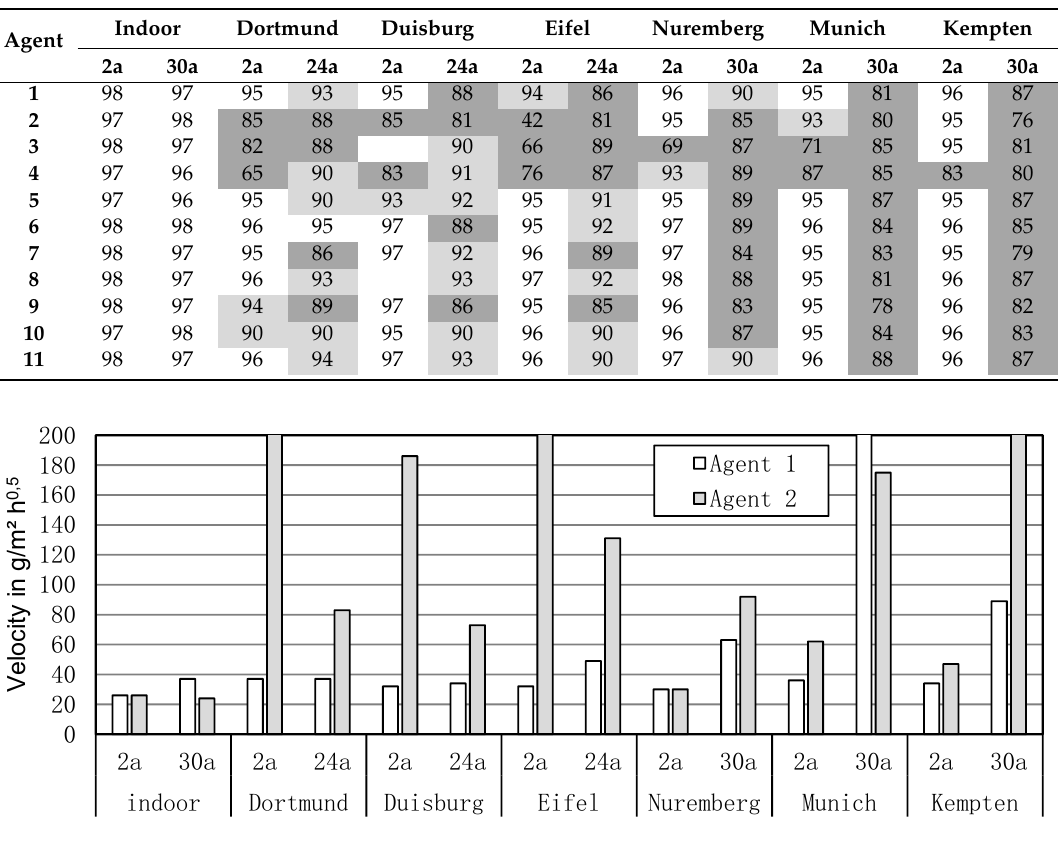
Figure 7. Velocity of water uptake between 5 and 120 min for OKS samples treated with agents 1 and 2 and weathered at the 7 different locations.